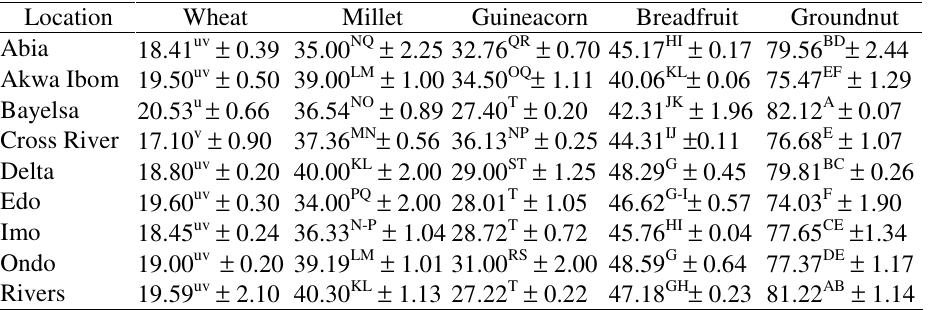
(µg kg -1 )* in food grains from markets in Nigeria 1